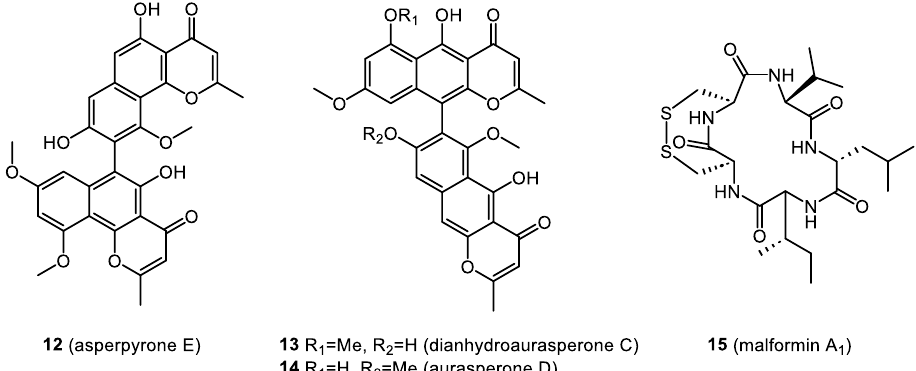
Figure 4. Bryendophyte metabolites ( 7 – 15 ) with cytotoxic and anticancer activities.